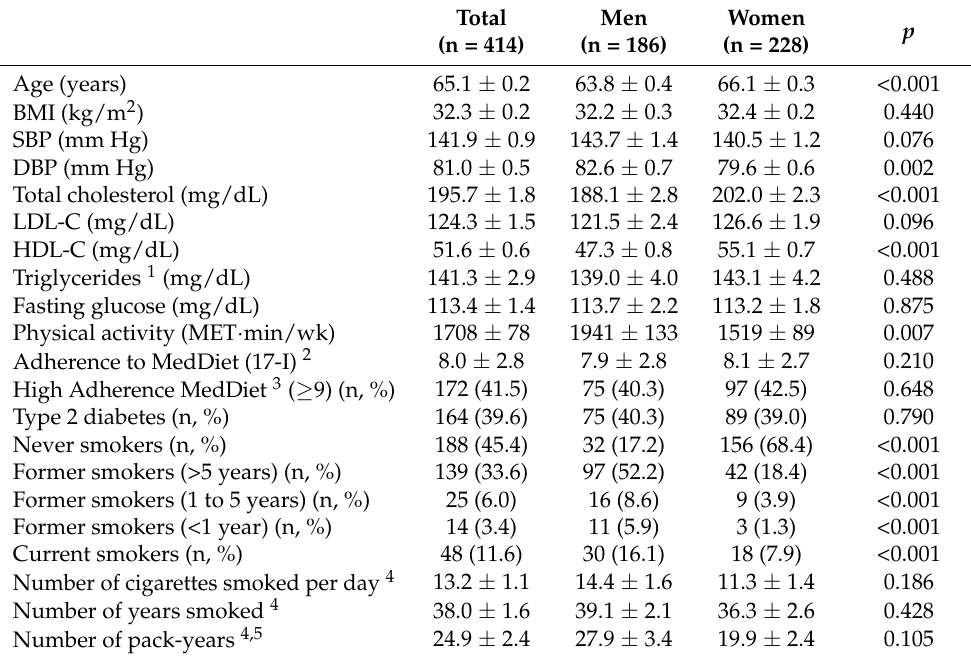
Table 1. Demographic, clinical and lifestyle characteristics of the study population according to